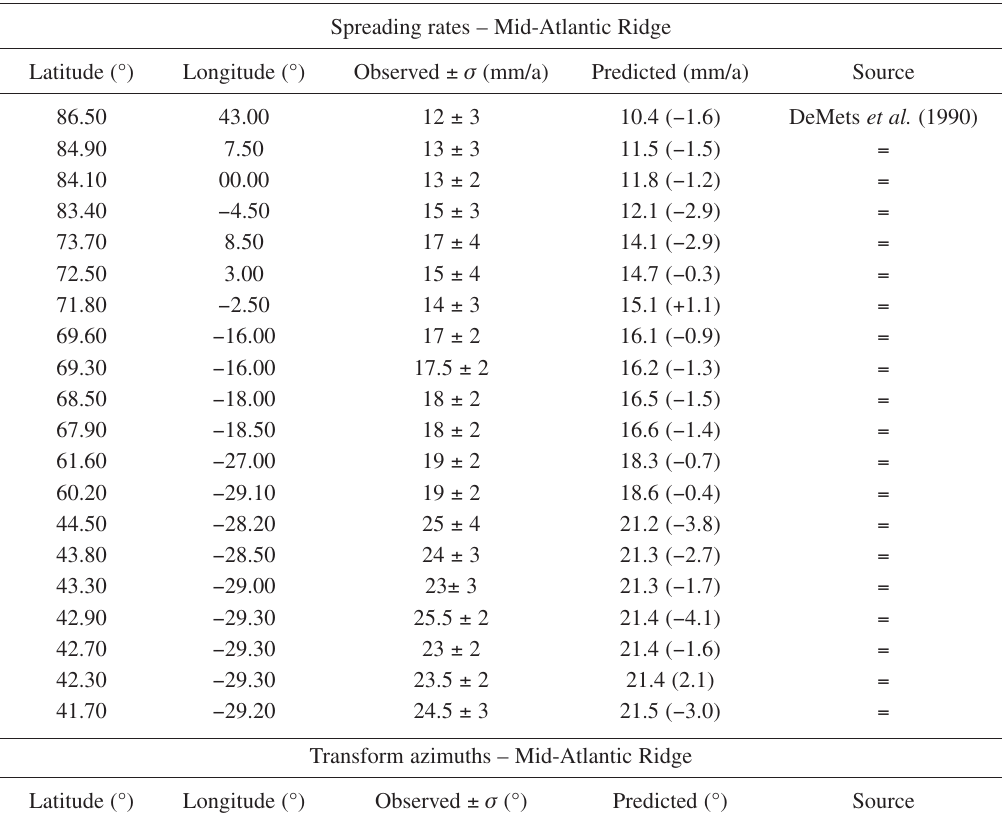
Table IIa-i. Mediterranean and North Atlantic constraints (ridge spreading rates, transform fault azimuths and plate velocity vectors) considered in the search of the kinematic solution reported in table I. For each plate boundary (see figs. 3 and 4), the relevant kinematic constraints, along with the related standard deviation σ and the respective values predicted by the related Euler pole (table I), are reported. The differences between predict- ed and observed values are given in brackets. See text for